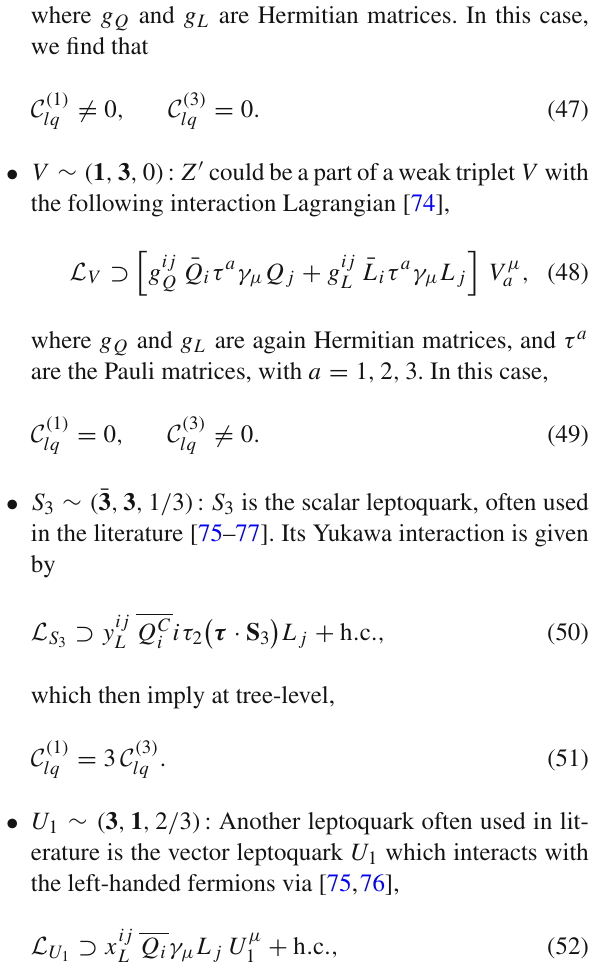
Fig. 6 The ratios R tom and top right panels) normalized to their SM values, in the region q 2 ∈ [ 1 . 1 , 6 ] GeV 2 , and plotted against δ C New Physics scenarios with left-handed couplings to muons, see Sect.